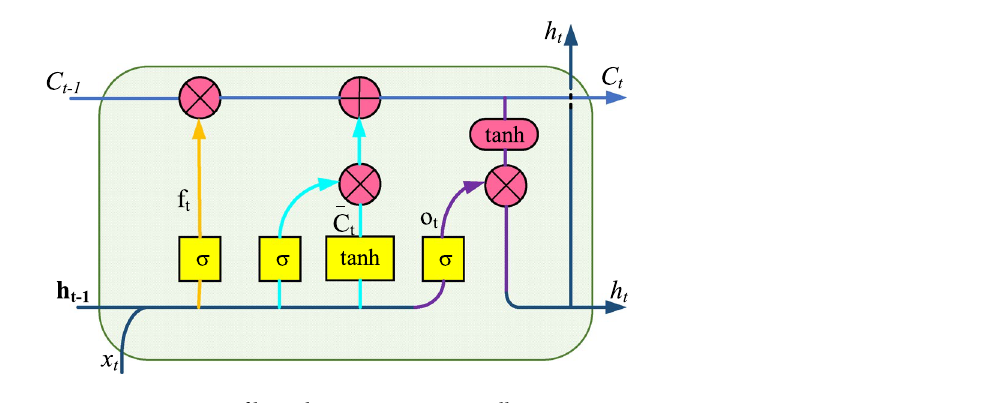
Figure 5. Structure of long short-term memory